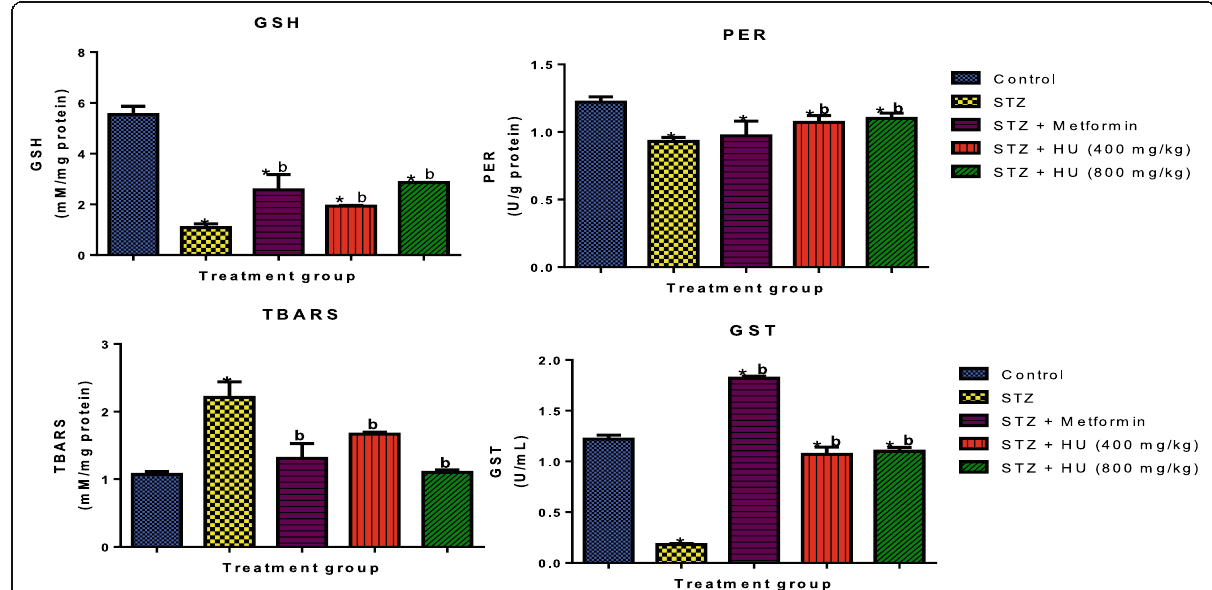
Fig. 2 Effect on oxidative markers in the kidney. Superscripts * a b represent values that are significantly (p < 0.05) different from negative control, metformin treated group and positive control respectively. GSH, TBARS, PER, GST, STZ and HU represents reduced glutathione, thiobarbituric acid